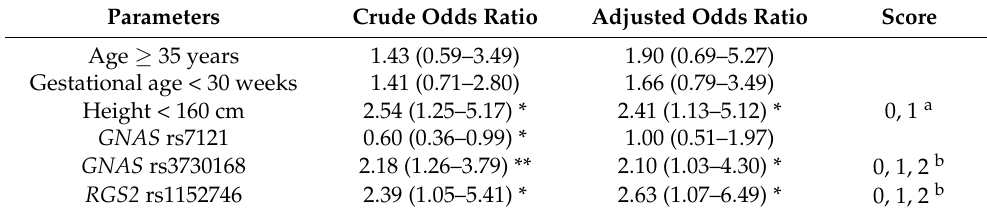
Table 3. Multivariable analysis and risk scoring system for ritodrine-induced adverse